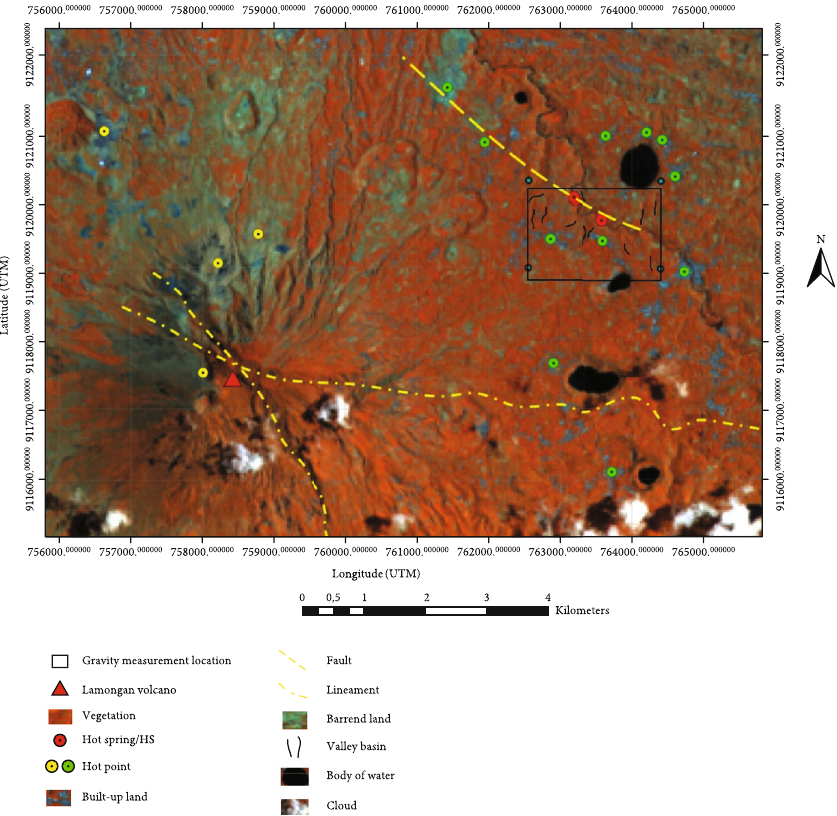
Figure 8: Map of composite results of Band 567 geothermal area of the Lamongan Volcano complex